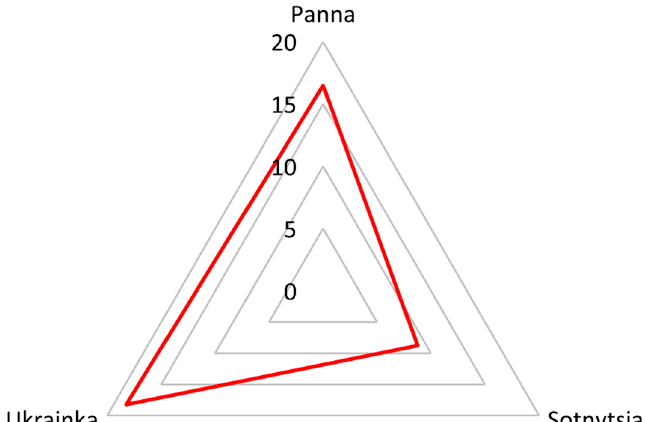
Figure 3. The proportion of grain protein groups differentially accumulated among investigated Triticum aestivum L. cultivars revealed the most diverse non-gluten fraction. Information about the functional role of proteins was extracted primarily from UniProt.